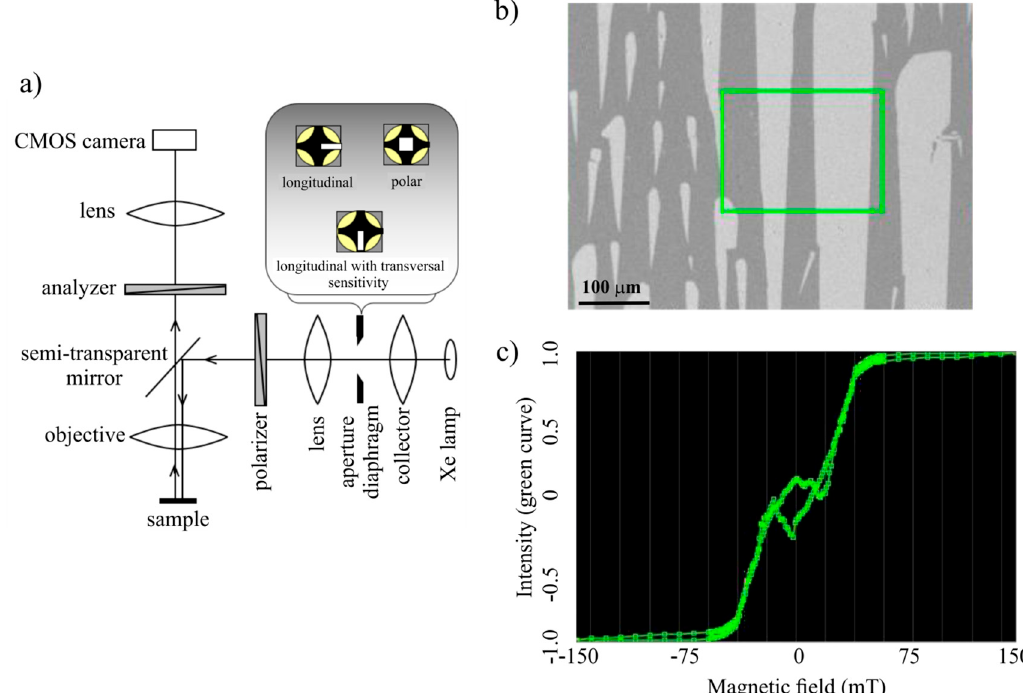
Figure 1. ( a ) Schematic representation of the optical part of a magneto-optical Kerr microscope. ( b ) Observed magnetic domain patterns and choice of sample surface area using the region of interest (ROI) tool (green rectangle). ( c ) Surface hysteresis loop corresponding to the selected surface area.